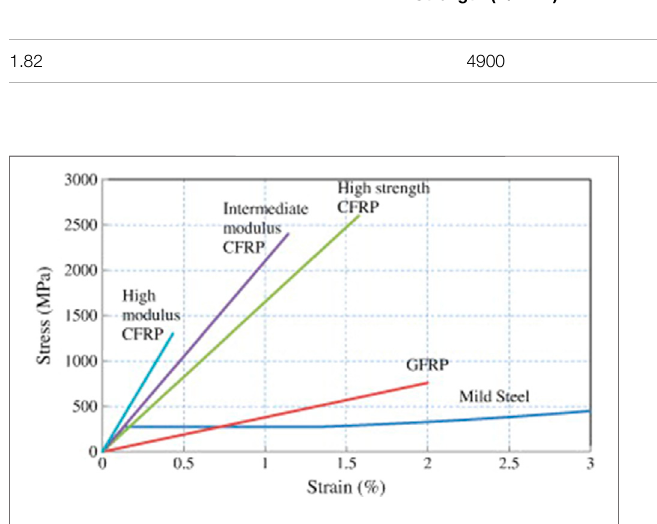
FIGURE 1 | Comparison of the stress-strain relationships for CFRP and other materials (Teng et al., 2012).